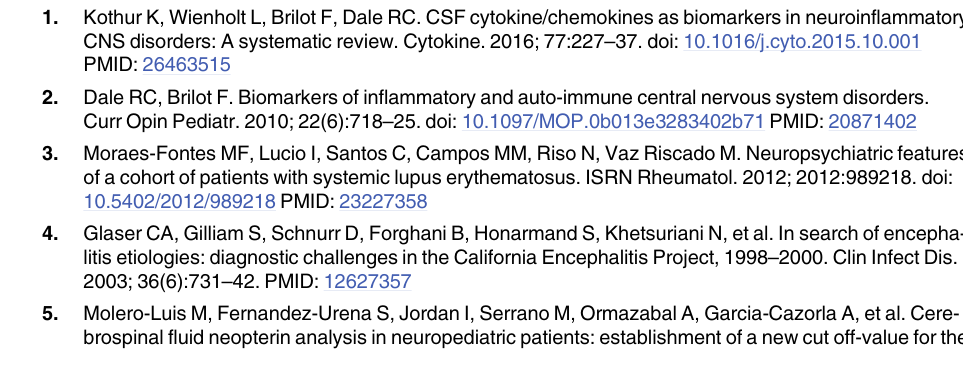
S1 Fig. CSF cytokine and chemokine concentrations among ADEM # , anti NMDAR E and EVE groups according to T and B cell effector groups. # MOG antibody positive demyelin- ation is shaded blue and MOG negative is shaded black in ADEM group. S1 File. Table A. The detectability of CSF cytokine/chemokines in controls. Table B. Compar- ison between median CSF cytokine and chemokine concentrations in ADEM, anti NMDAR E and EVE groups according to T and B cell effector groups. Table C. Key Cytokine/chemokines, their cellular source, cellular target, role in neuroinflammation, and association with neuroin- flammatory disorders and other neuroinflammatory